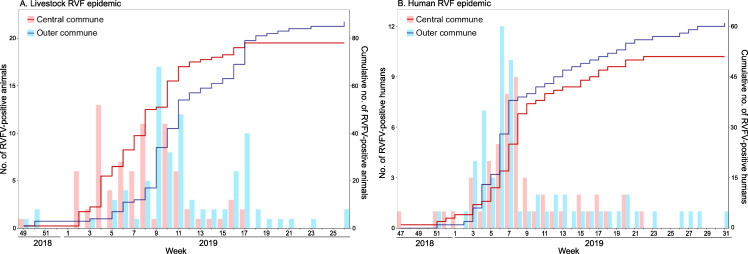
Weekly number of Rift Valley fever virus (RVFV) RT-PCR positive (A) animals and (B) humans in central or outer communes. The bar plots show the weekly number of RVFV-positive cases (left y-axis), and the solid lines their cumulative distributions (right y-axis). Central communes are colored in red and outer communes in blue.